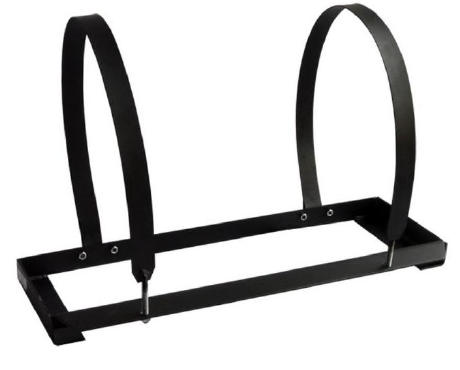
Fig. 2. A frame for a cylindrical LPG tank [9